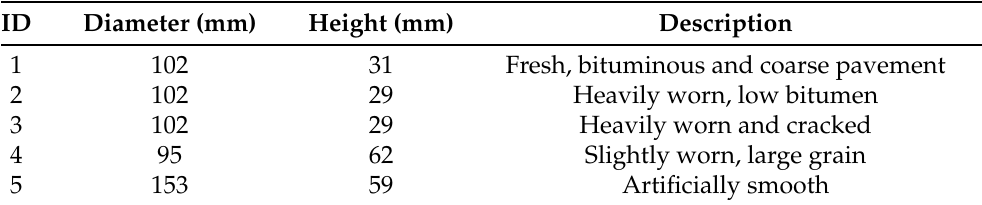
Figure 2. Pavement samples used for reference measurement. Samples in ID number order, from left to right, 1–5. Table 7. Pavement samples used for reference